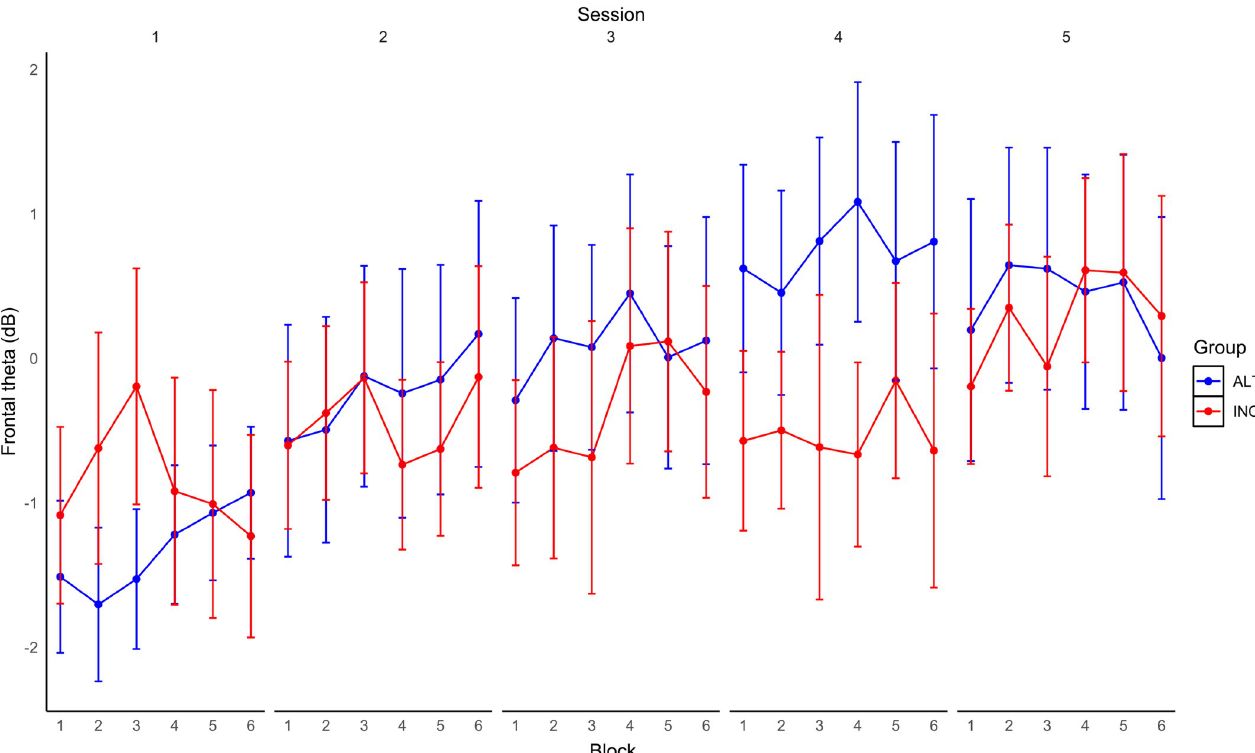
Fig 4. Fm θ changes within and across sessions for each group during NF. Changes in Fm θ over Blocks and Sessions of NF training for each Group (error bars are SE).